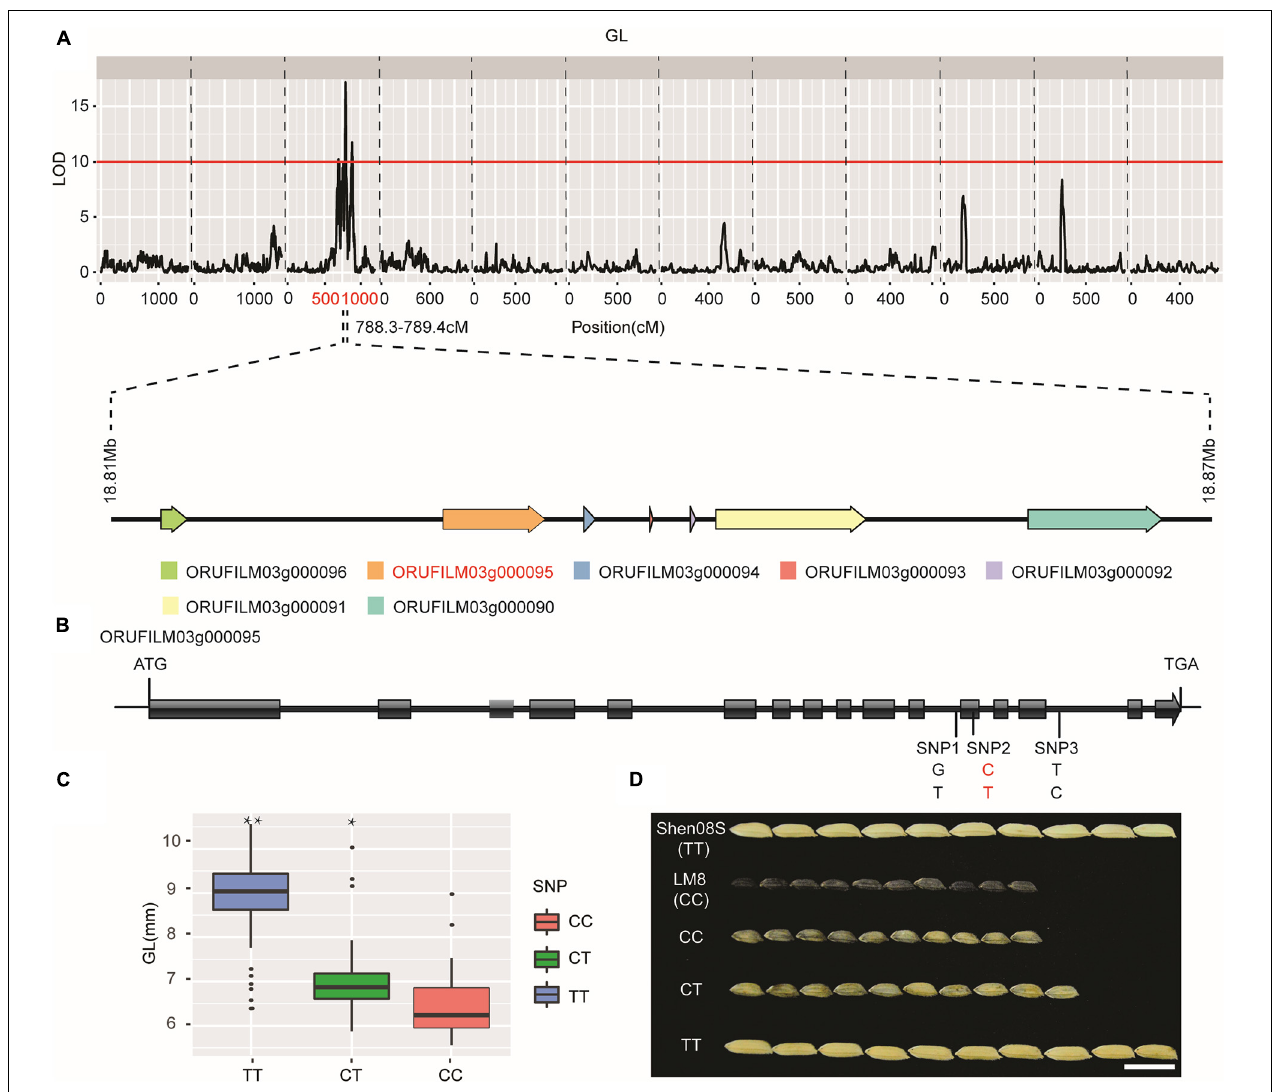
FIGURE 3 | QTL for grain length and prediction of candidate genes. (A) QTL mapping results for grain length and seven putative genes ( ORUFILM03g000096 , ORUFILM03g000095 , ORUFILM03g000094 , ORUFILM03g000093 , ORUFILM03g000092 , ORUFILM03g000091 , and ORUFILM03g000090 ) within the region. (B) Gene structure of ORUFILM03g000095 (top), (C) grain length (GL) distribution in each genotype of ORUFILM03g000095 , (D) corresponding GL phenotypes in F 2 individuals (lower right). Asterisks is correlation between genotype and phenotype, * P < 0.05. ** P <